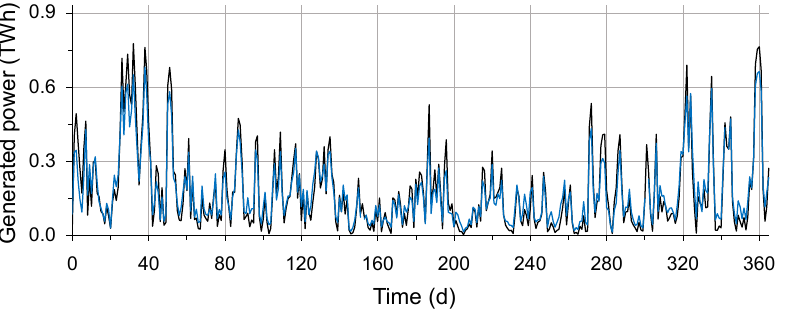
Figure 9. Simulated electricity production (black line) and measured feed-in data (blue line) from wind turbines in Germany for 2016 with a daily resolution.